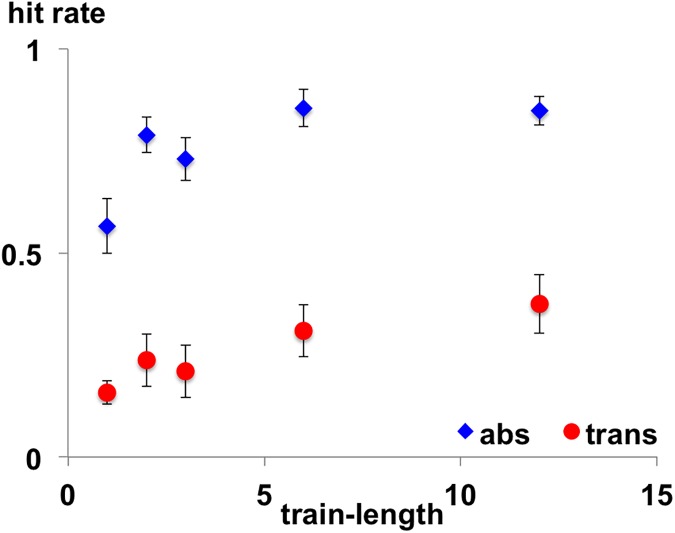
Hit rates in the active behavioral detection task.Proportions of hits (N = 18) for the absolute repetition condition (blue triangles) and the transposed repetition condition (red dots) on deviant sound patterns as a function of the number of preceding standard sound patterns are shown. Whiskers indicate standard errors of mean.